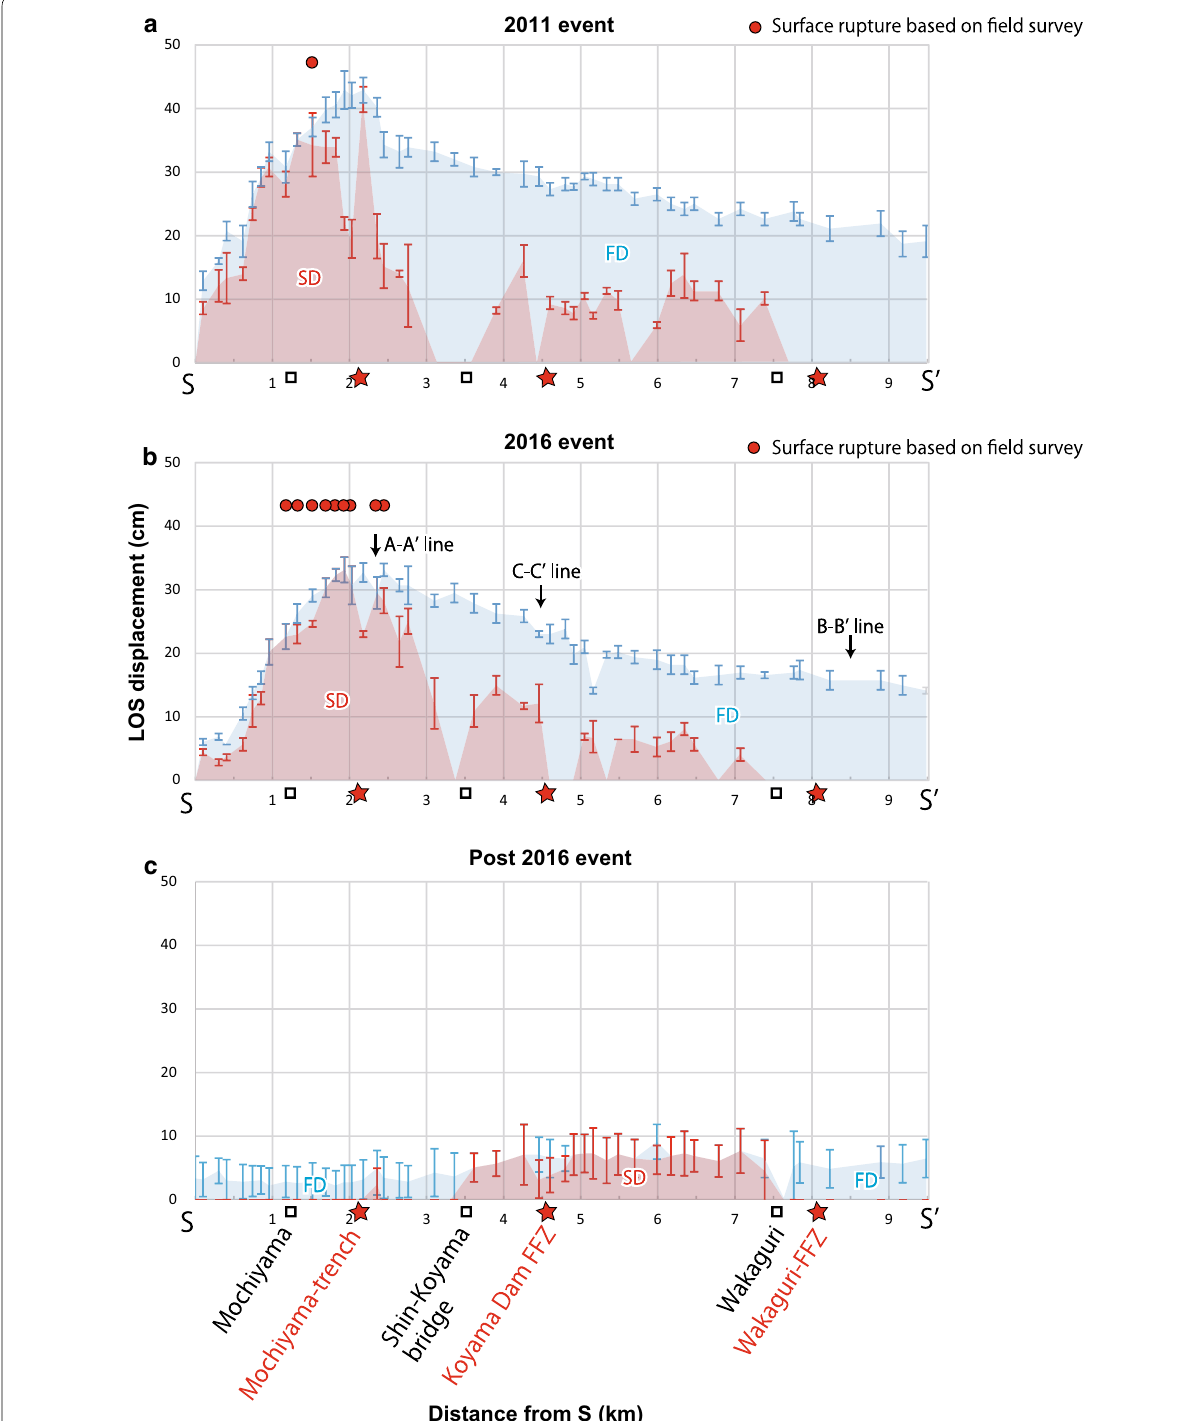
Fig. 4 Distribution of relative displacement along line S–S ′ (location in Fig. 2a–c) based on LOS offset maps for a the 2011 event, b the 2016 event, and c the post-2016 event period. Red shading and error bars represent SD and blue shading and error bars represent FD. Red circles are locations of tectonic surface ruptures along line S–S ′ . The position of cross-section lines (Figs. 2b, 3) are also shown in